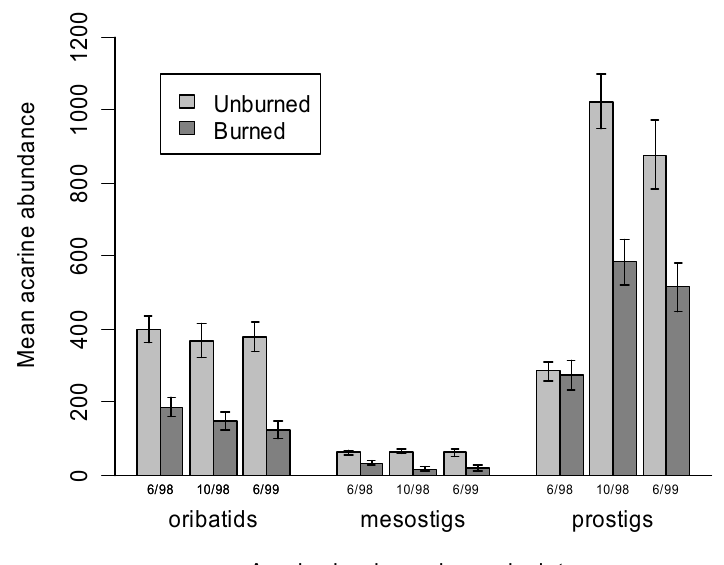
Figure 1. Mean abundance per sample of mite suborders Oribatei, Mesostigmata, and Prostigmata ± SE in burned and unburned split-plots during each of the three sampling periods (June 1998, October 1998, and June 1999).